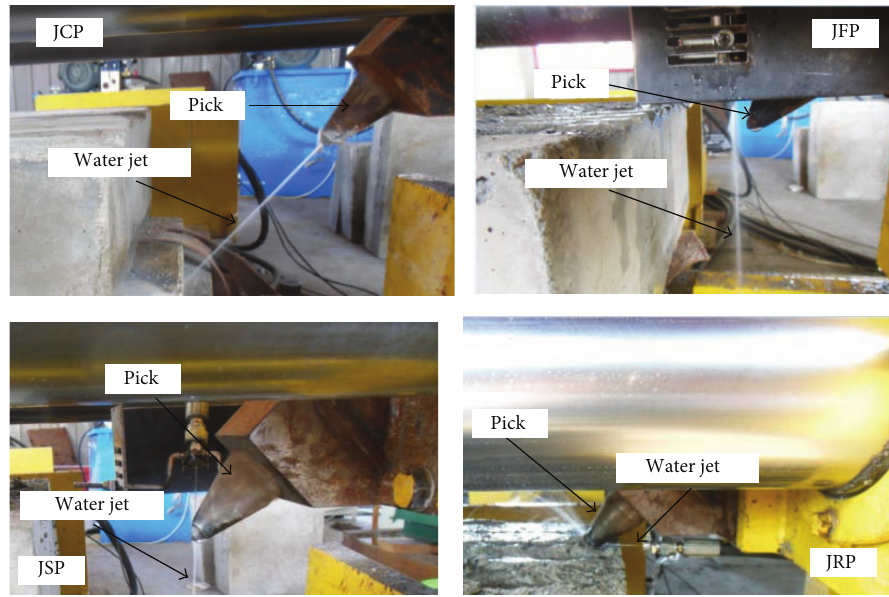
Figure 2: Different configuration modes of water jet.